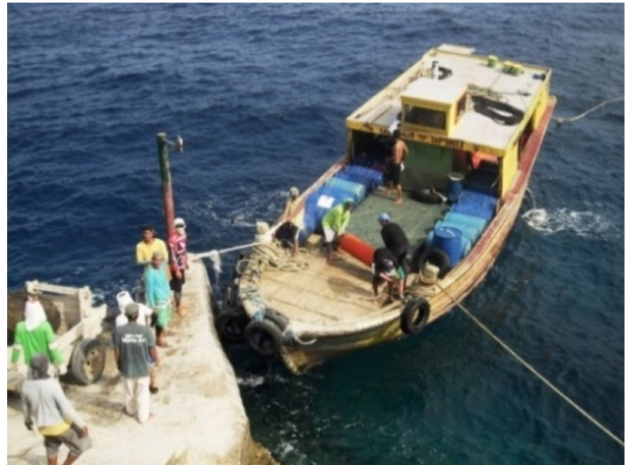
Figure 6. Fuel supply chain in Basco.